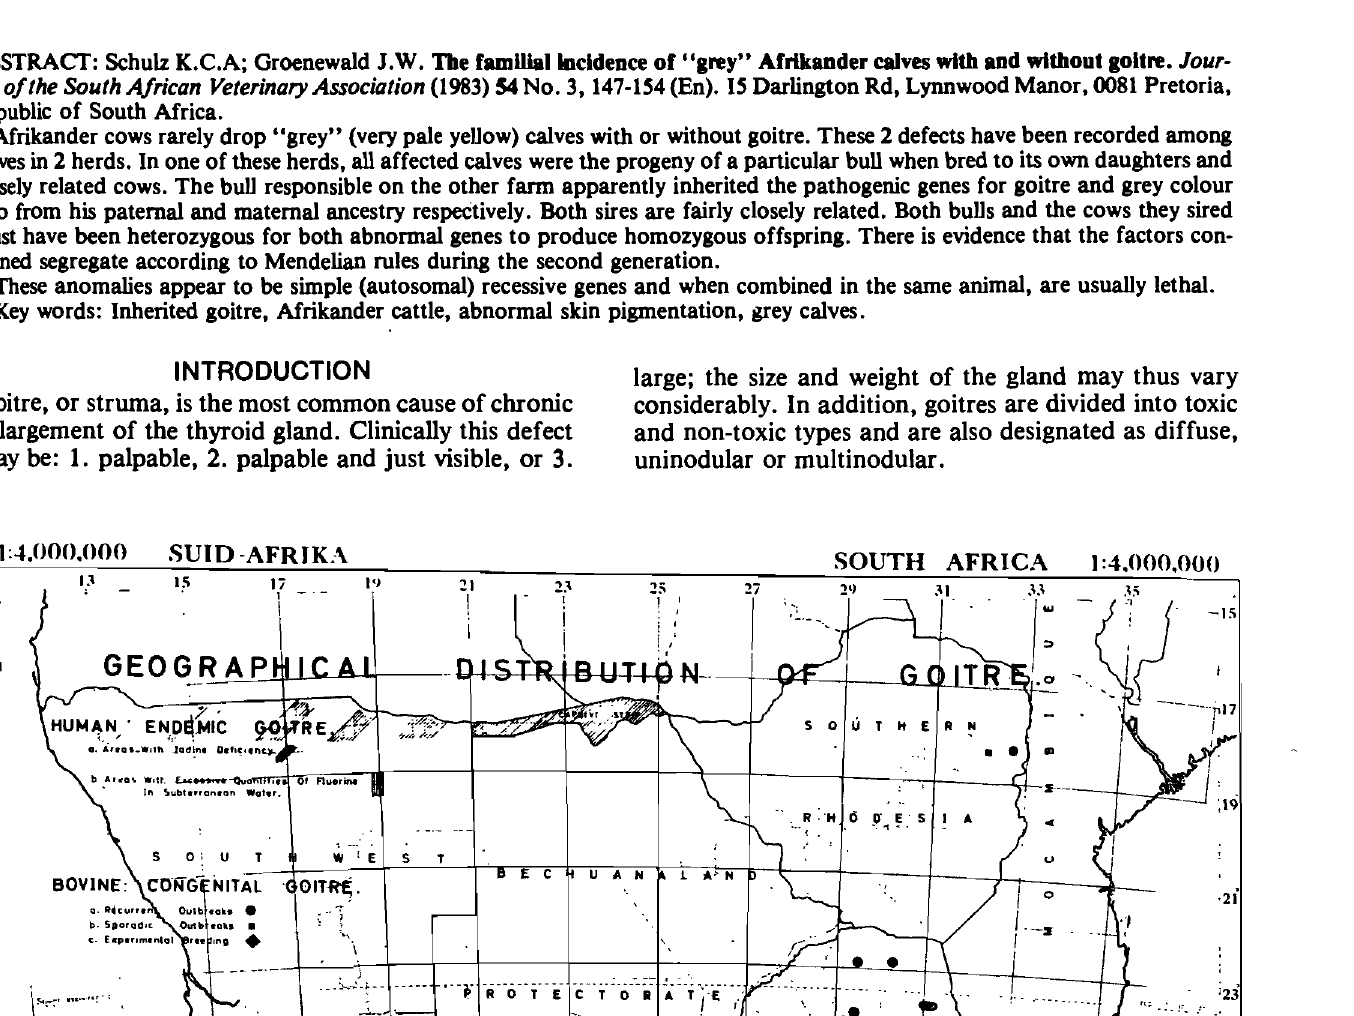
-IS Darlington Rd, Lynnwood Manor, 0081 Pretoria, Republic of South Africa. --Knysna, Cape